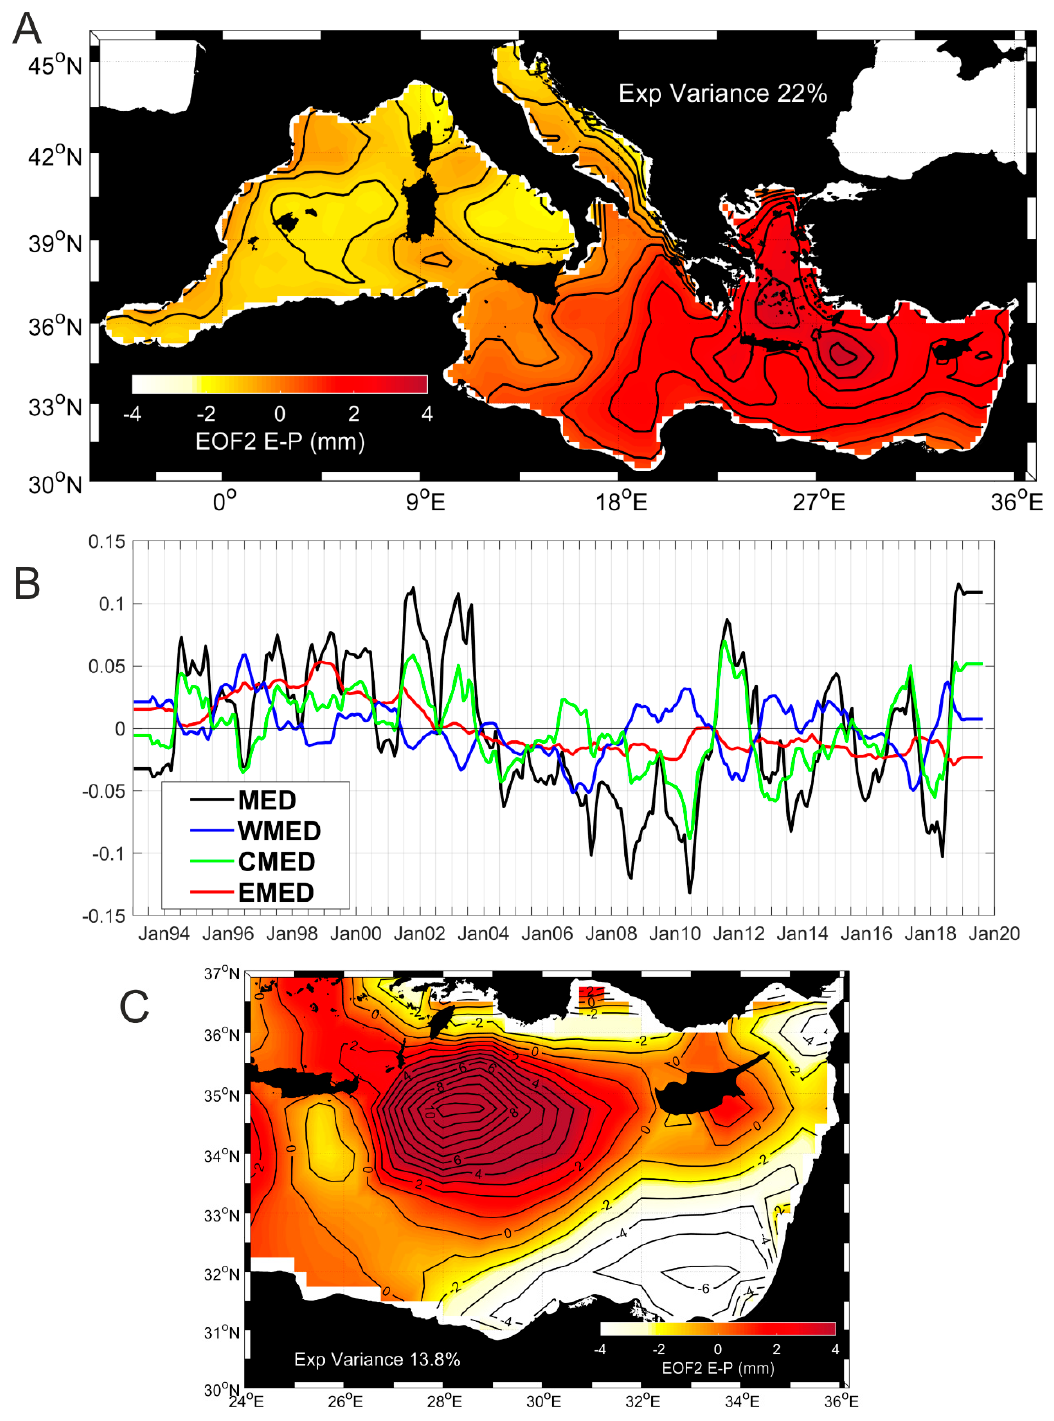
Figure 9. EOF2 ( A ) and PC2s ( B ) of the E-P. EOF2 of the EMED ( C ). Figure 8. EOF2 ( A ) and PC2s ( B ) of the E-P. EOF2 of the EMED ( C